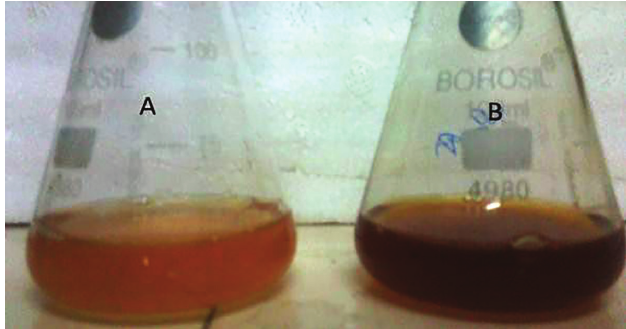
FIGURE 1 - Flasks showing only the cell filtrate (A) and cell filtrate with AgNO (B). Change in color in flask B shows the 3 formation of silver nanoparticles.